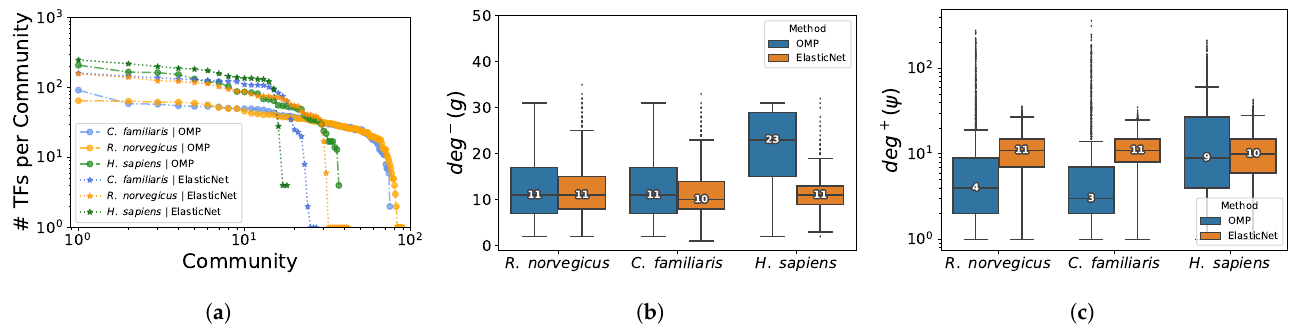
Figure 5. Number of TFs within each community (sorted in decreasing order) from the C. familiaris ,